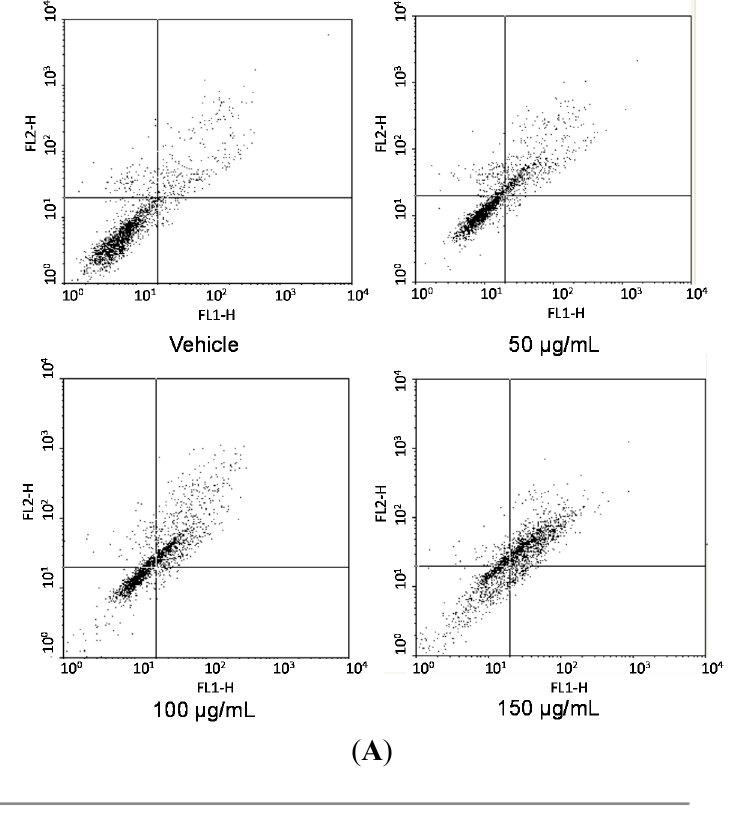
Figure 3. Effect of SOE on RL95-2 cell apoptosis. ( A ) The RL95-2 cells (2 × 10 5 cells/well) were incubated for 48 h with DMSO only (vehicle, 0.1% v/v) or media containing 50–150 μ g/mL SOE. The treated cells were stained with Annexin V-FITC solution and analyzed by flow cytometry. ( B ) Cell distribution under the treatment with 0–150 μ g/mL of SOE for 24, 48 and 72 h. Lower left (LL) quadrant: viable cells; lower right (LR) quadrant: early apoptotic cells; upper right (UR) quadrant: late apoptotic cells; upper left (UL) quadrant: necrotic